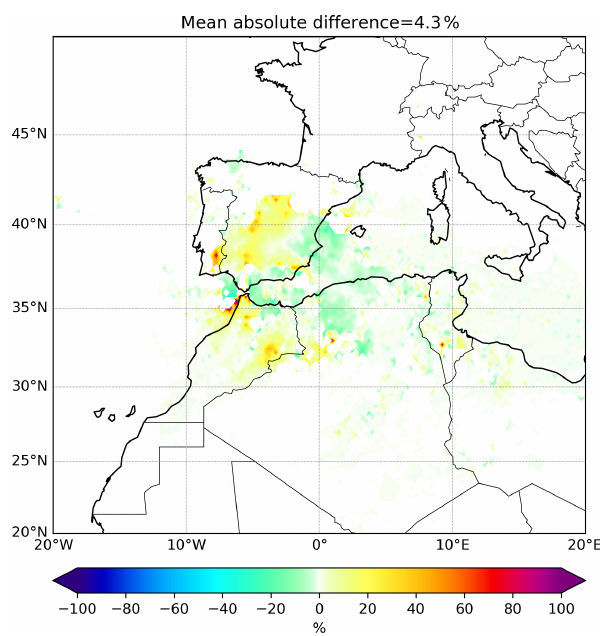
Figure 9. Relative difference (%) between E – P field values calcu- lated considering humidity phase changes and without considering them. The domain has been cropped with respect to Figs. 4 and 7 because the values outside the shown area are very small.